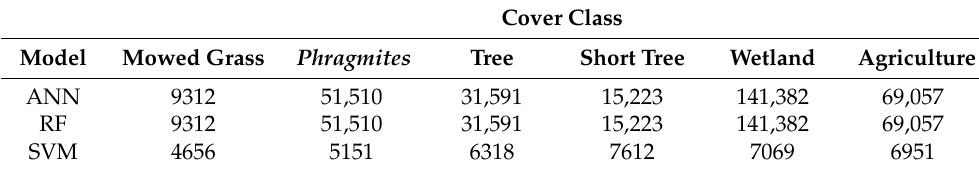
Table 8. Number of training samples per cover class for each machine learning